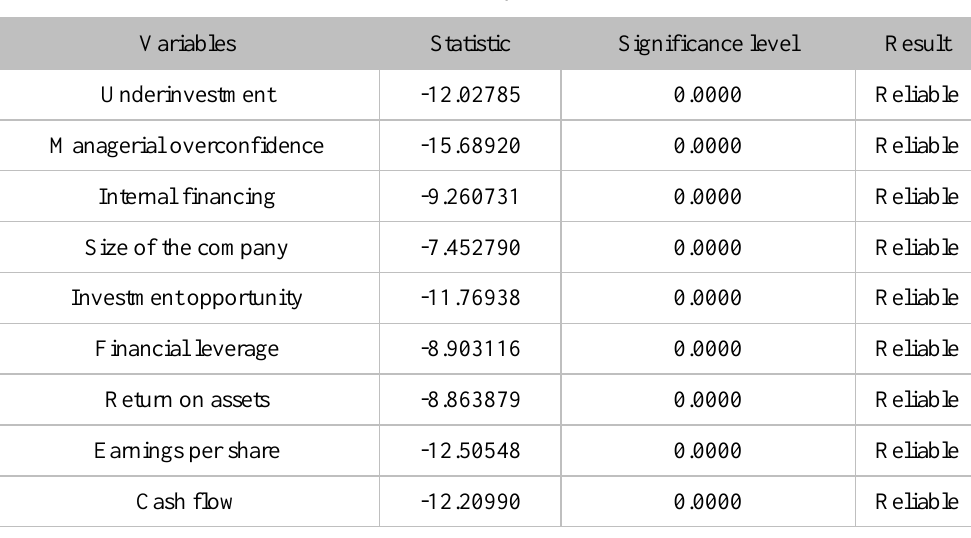
Table 7. Variables reliability test -